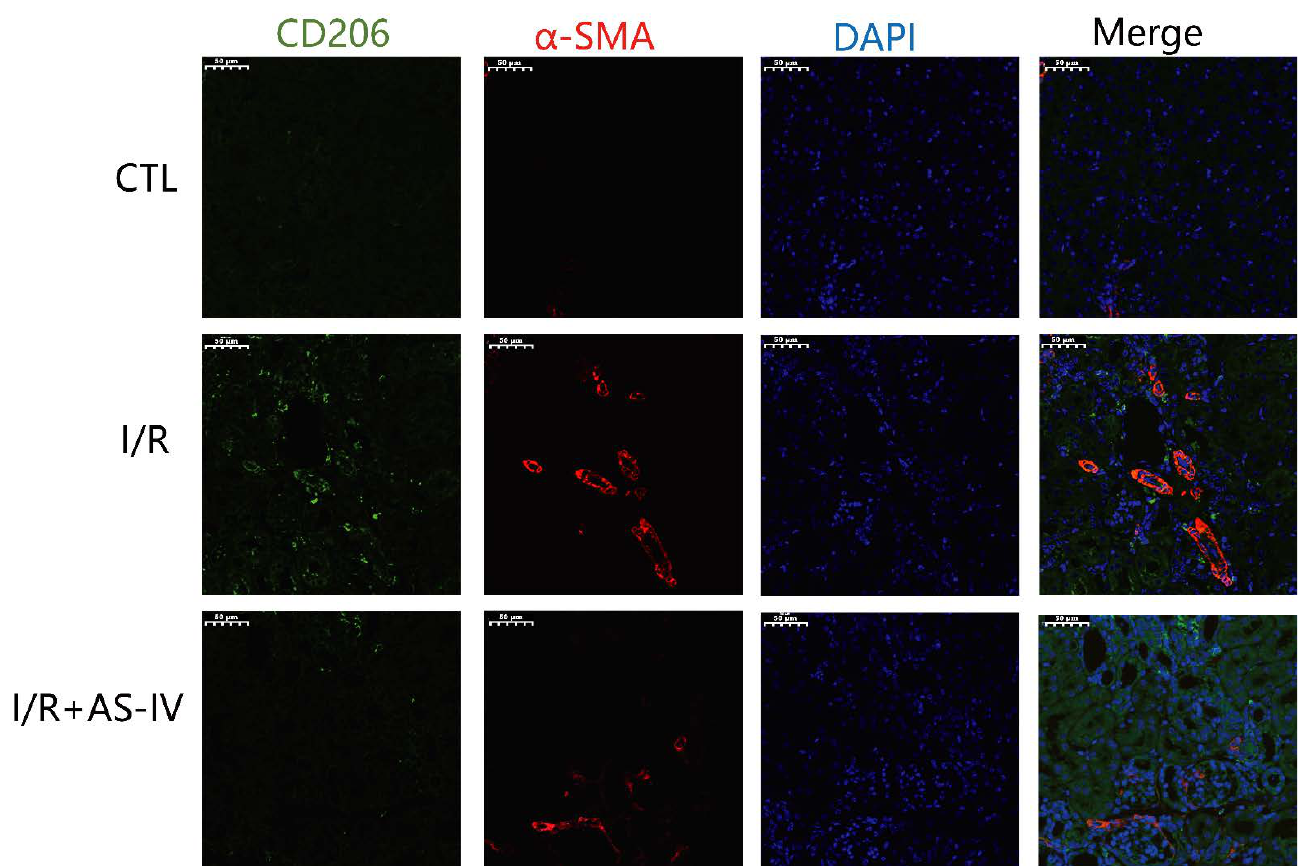
Figure 7. AS-IV reduces infiltrated M2 macrophages in the renal interstitium 28 days after I/R. Representative immunofluorescent co-staining images of CD206 and α -SMA in the renal interstitium (magnification × 200). Green corresponds to CD206, red corresponds to α -SMA, and blue corresponds to nuclear staining (DAPI).